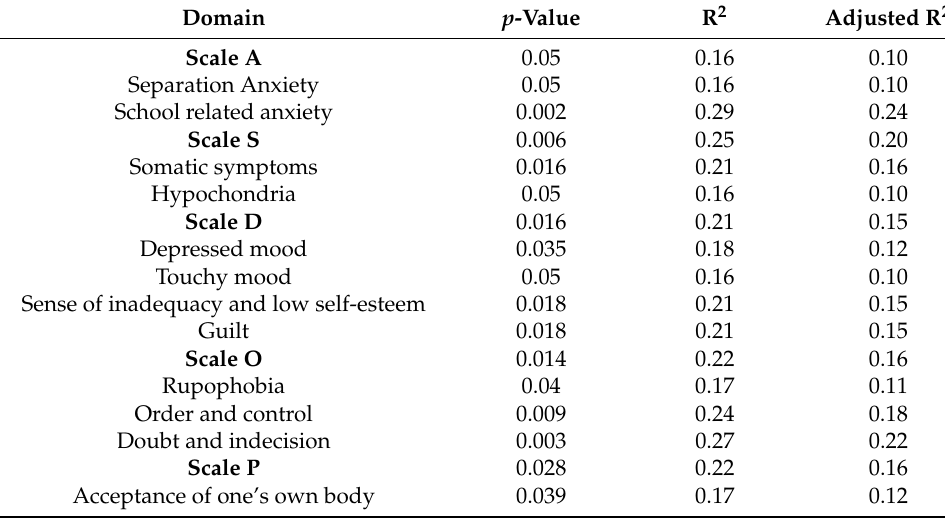
Table 5. Age-and sex-adjusted analyses of SAFA domains between EG and